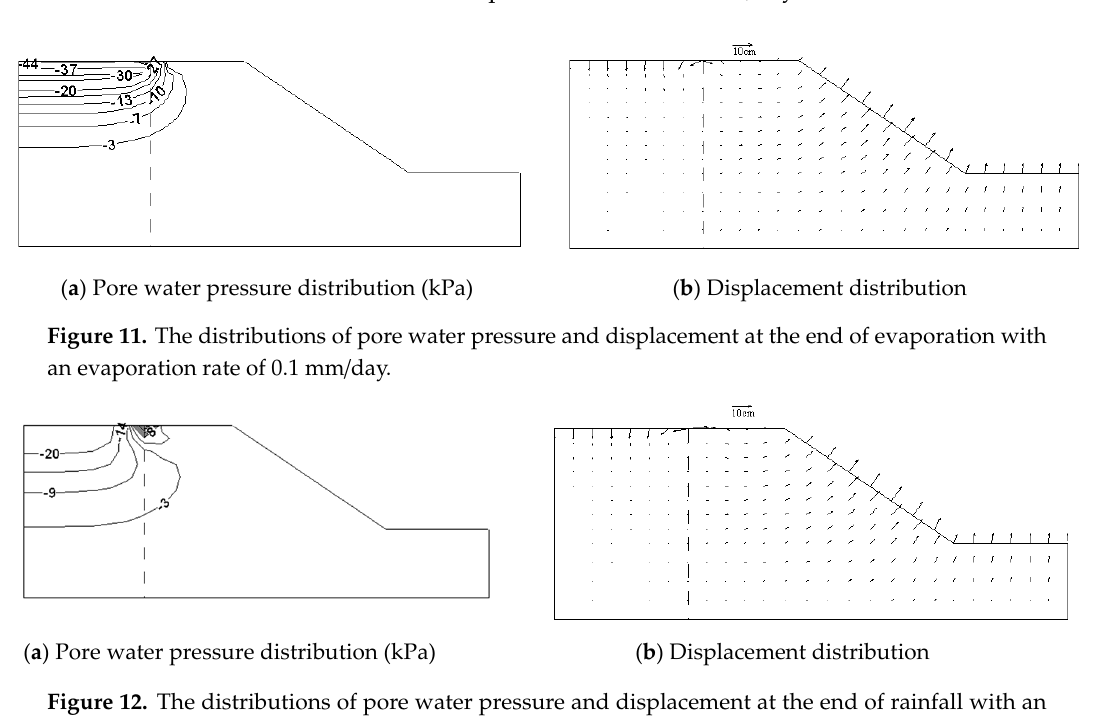
Figure 10. Crack-width–time curve under different discharge speeds after 800 days.